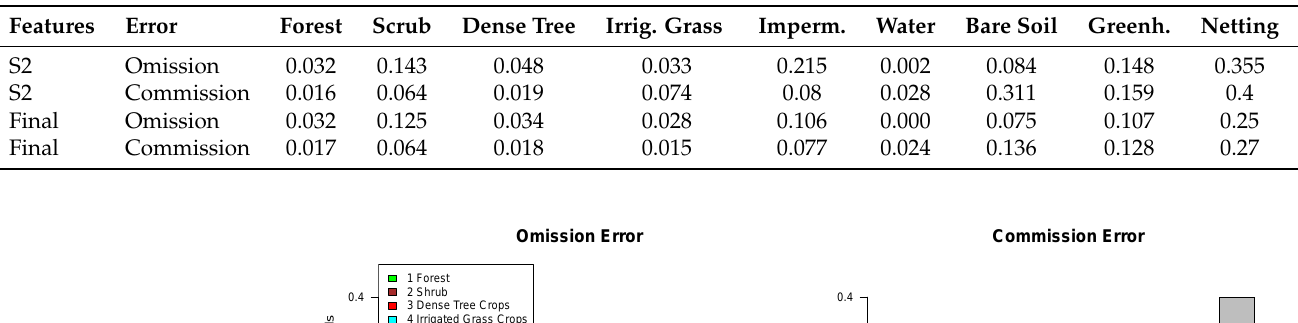
Table 7. Omission and commission errors of the S1+S2 and the final classification.